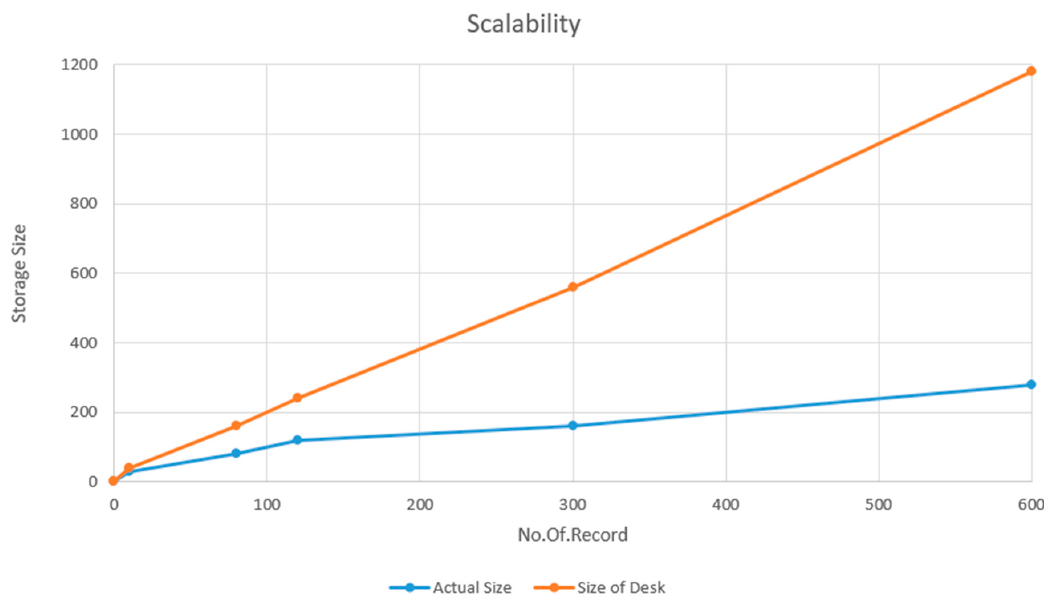
Figure 10. Scalability.